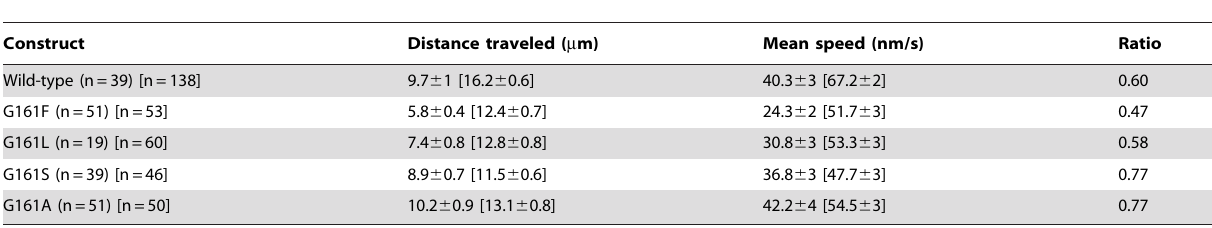
Table 1. Mean speeds and travel distances of DII-core coated LDs compared to LDs in [mock transfected] Huh-7 cells a .